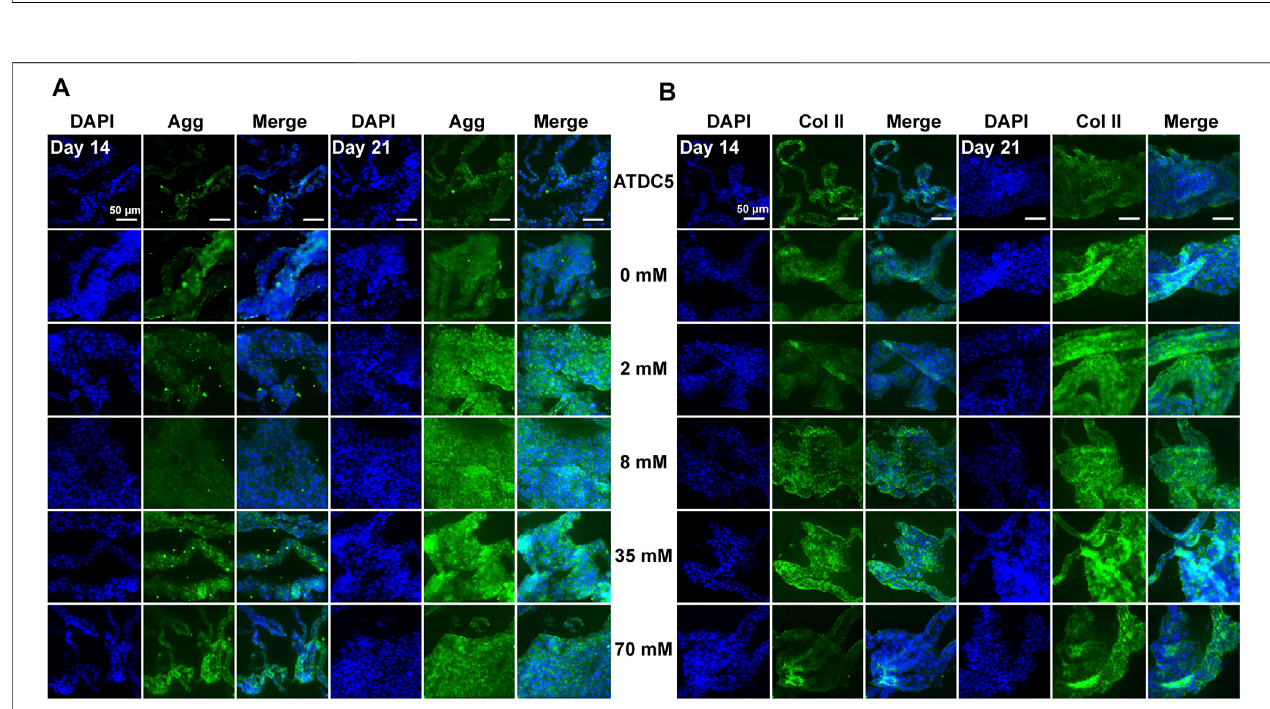
FIGURE 2 | Immuno fl uorescence staining for the chondrogenic markers (A) aggrecan and (B) type II collagen of ATDC5. Aggrecan and type II collagen were stained green and nuclei were stained blue. Scale bar = 50 µm.